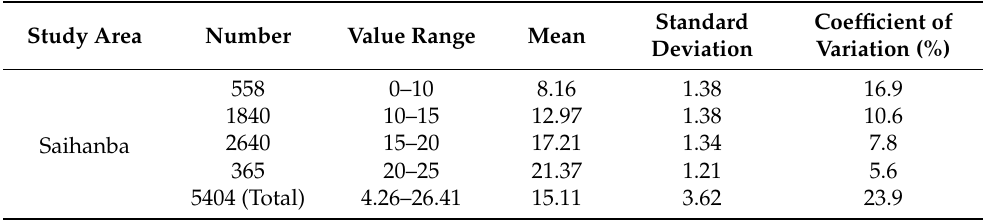
Table 3. The 98% vegetation canopy height obtained from the ATL08 data in the Saihanba forest